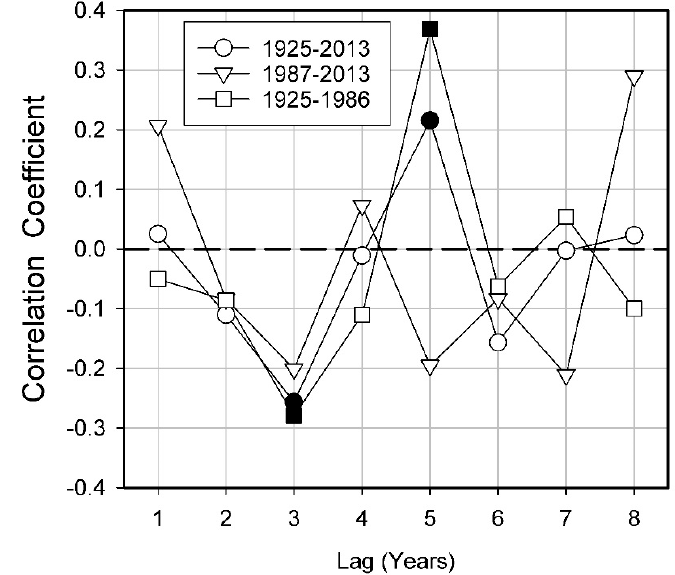
Figure 7. Autocorrelation of estimated annual basin precipitation inputs based on historic station data, gridded data and the combined standardized precipitation index. The significant correlations are shown by filled symbol.